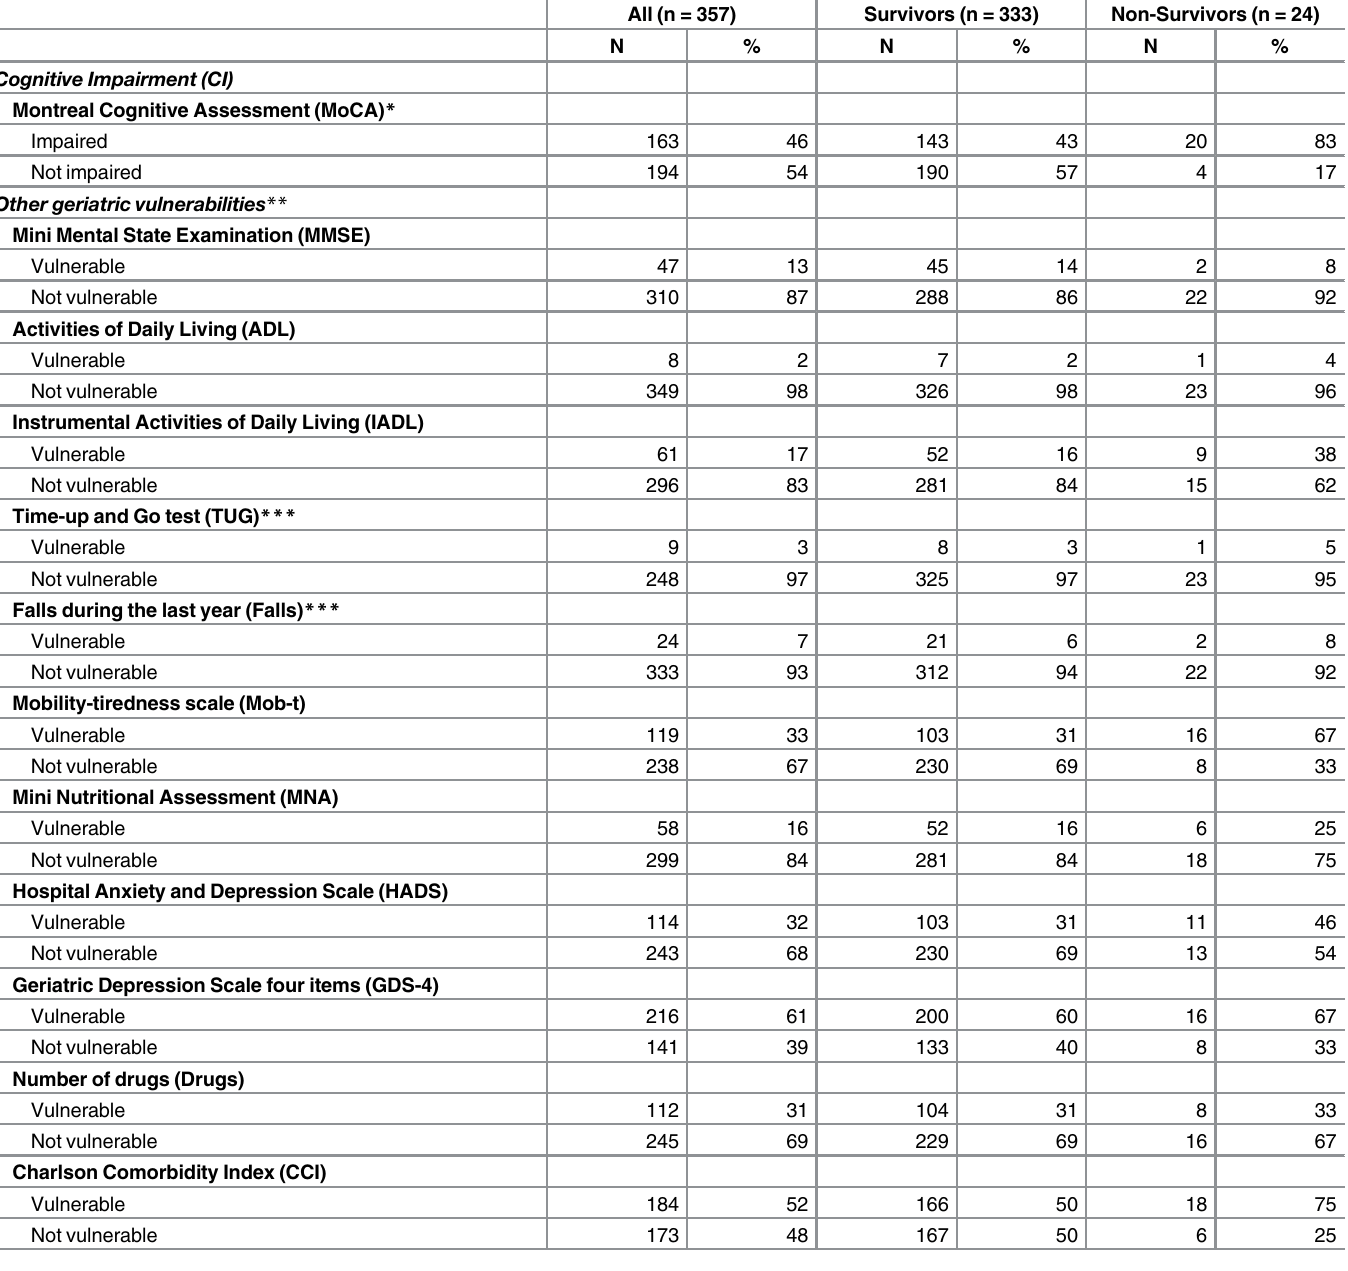
Table 2. Cognitive Impairment (CI) and other geriatric vulnerabilities of older patients at the time of cancer treatment initiation, stratified for Survi- vors/Non-Survivors at 2 years (n = 357).